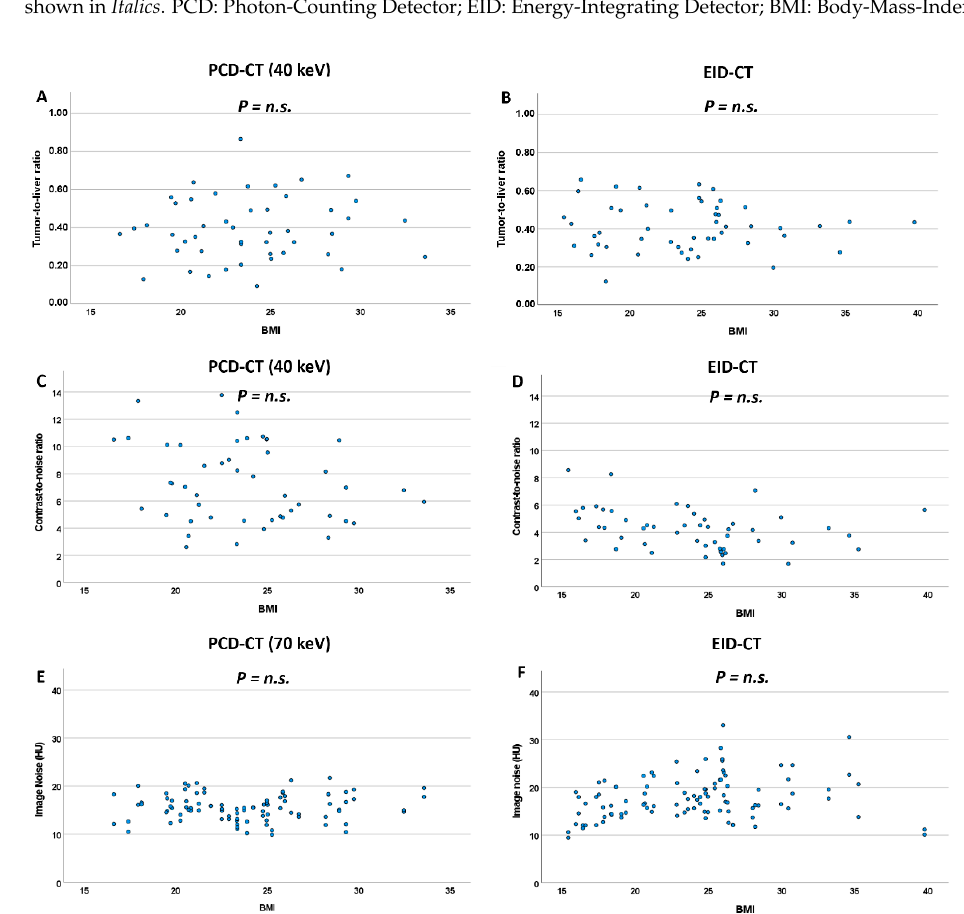
Table 3. Image noise at different keV levels in BMI-subgroups after median split.